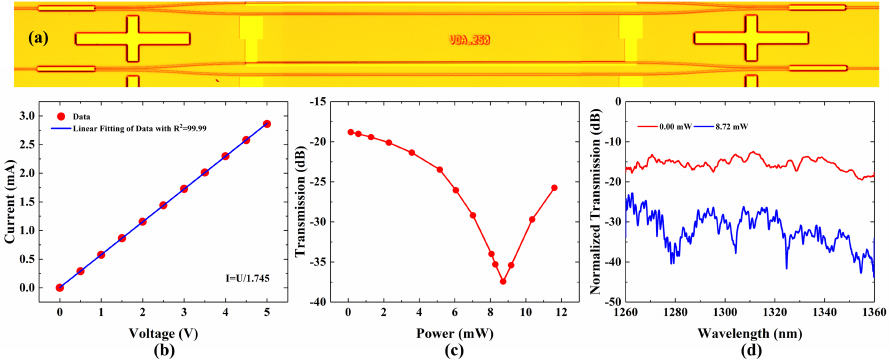
Figure 3. ( a ) Microscopic image of the proposed VOA; ( b ) Measured current-voltage (I-V) curves of the VOA; ( c ) Measured Transmission-Power (O-P) curves of the VOA; ( d ) Normalized transmission spectra of the VOA under 0.00 mW and 8.72 mW.